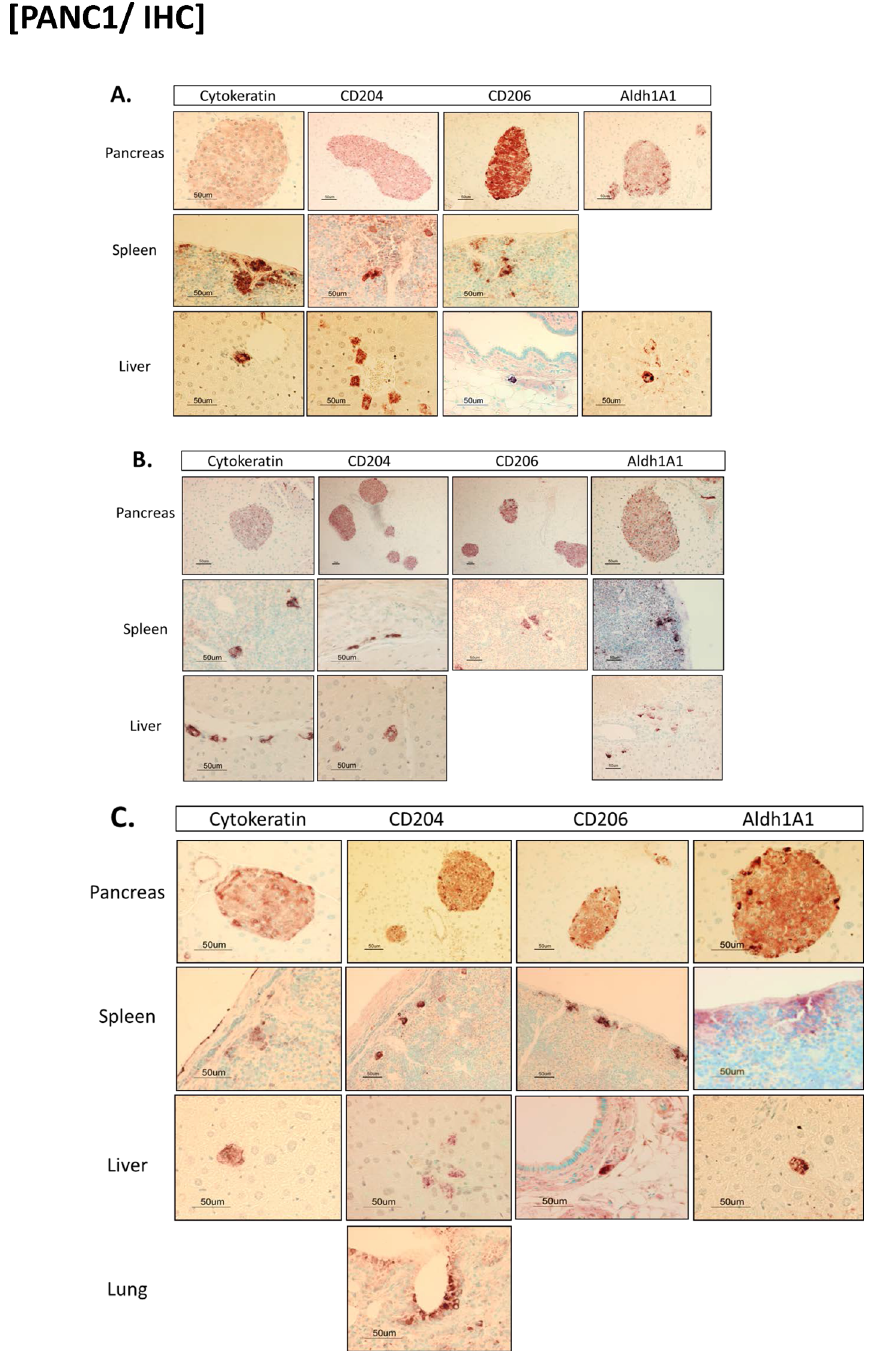
Fig 7. Immunohistochemical staining of mouse tissues after orthotopic transplantation of cultured MTFs. Human MTFs were culturedfrom blood as described,and orthopticallytransplanted into mouse pancreas. After variousperiods of time, tissues were harvested and stained for an epithelialmarker (cytokeratin, KRT), humanmacrophage M2 polarization markers CD204 and CD206, and humanpancreatic stem cell marker ALDH1A1.Tissues (pancreas, spleen,and liver) are as indicated. Panel A shows samples harvestedat 4 weeks after implantation, B shows samples after 8 weeks, and C shows samples after 12